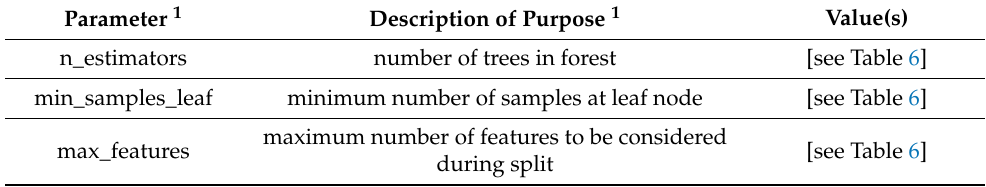
Table 5. User-defined parameters for random forest using RandomForestRegressor from the scikit- learn library. The remaining parameters were default; some parameters were not used until Grid- SearchCV (Table 6).